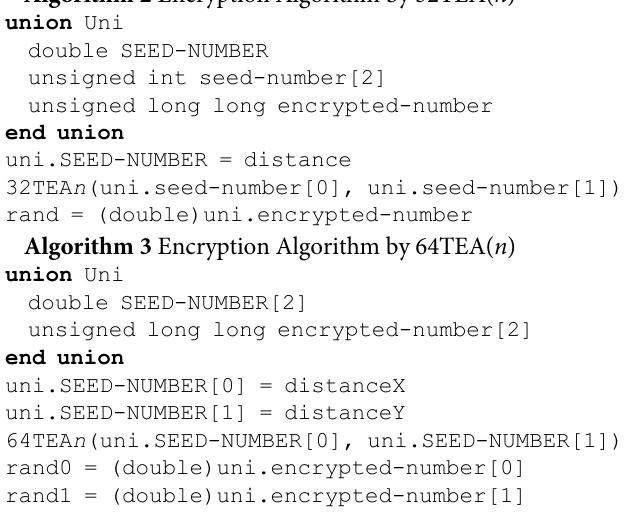
Algorithm 2 Encryption Algorithm by 32TEA( n )